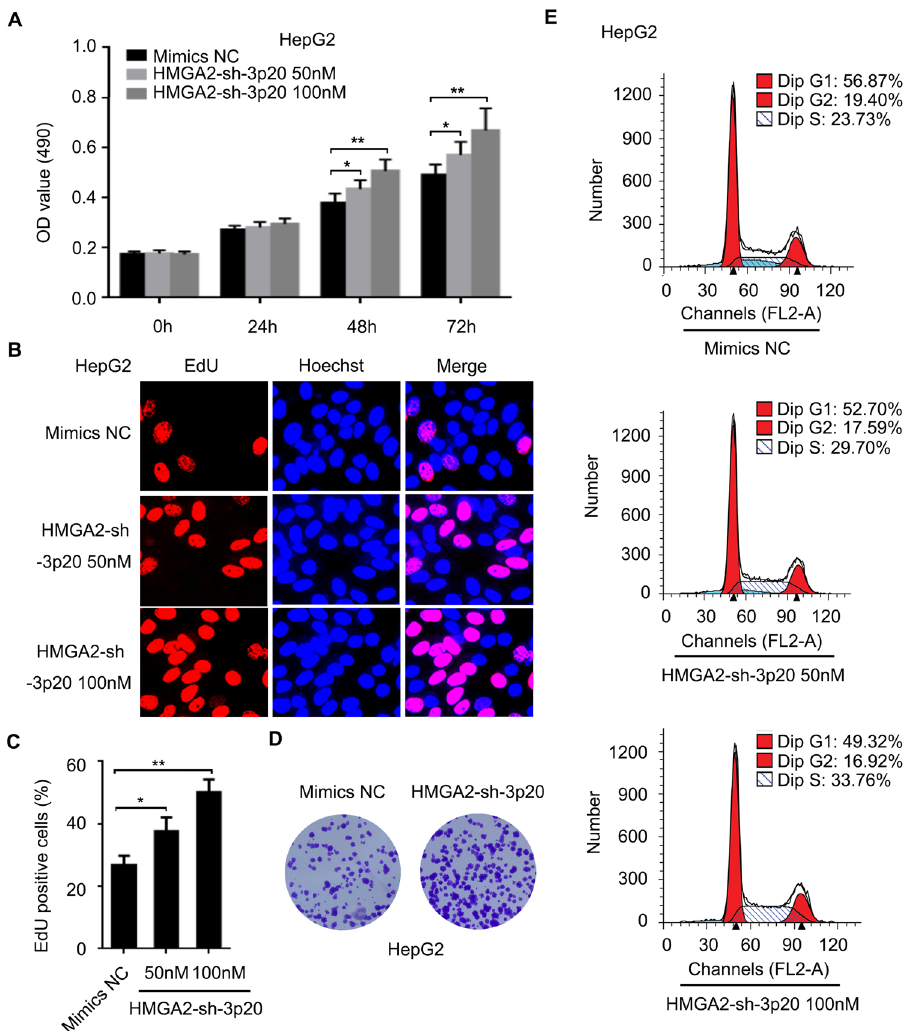
Figure 5. HMGA2-sh-3p20 contributes to the proliferation of hepatoma cells in vitro . ( A ) Effect of HMGA2- sh-3p20 on proliferation of HepG2 cells was determined by MTT assays. ( B , C ) Effect of HMGA2-sh-3p20 on proliferation of HepG2 cells was measured by EdU incorporation assays. ( D ) Effect of HMGA2-sh-3p20 on proliferation of HepG2 cells was assessed by colony-formation assays. ( E ) Effect of HMGA2-sh-3p20 on proliferation of HepG2 cells was tested by flow cytometry assays. Every experiment was repeated three times. Error bars represent s.d. (n = 3), ** p < 0.01; *** p < 0.001 and not significant (NS), Student’s t